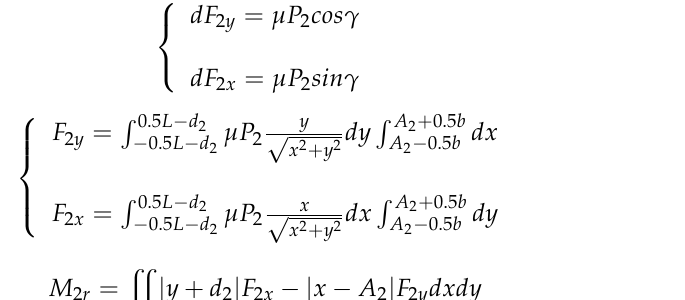
Figure 1. Friction between the roadheader and roadway. A coordinate system was established using the right track instantaneous velocity center as the origin, the roadheader’s excavating direction as the Y axis, and Y’s vertical axis as the X axis. γ is the angle between one point on the track and the instantaneous velocity center, and µ is the roadway floor resistance coefficient. Because there are different forces on different positions of the track, the resistance and moment can be solved by the unit force analysis method. The force at one point on the track is as shown in Formula (5). The floor frictional resistance to the track can be obtained by the integration of Formula (5), which is shown as Formula (6). d i and A i are the vertical and lateral offsets of the track instantaneous velocity center on both sides of the roadheader, b is the track width, and L is the track length. The steering resistance moment of the roadway floor can be determined by Formula (7).